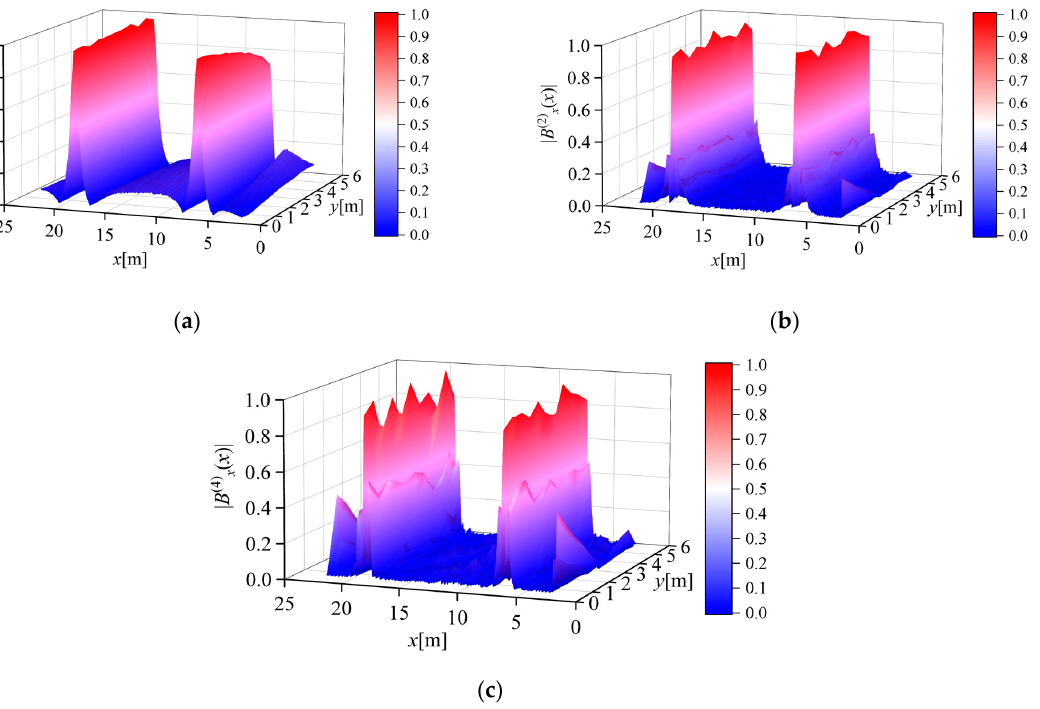
Figure 12. Normalized magnetic fl ux density absolute value measurement results when the measurement step size d = 0.05 m: ( a ) magnetic fl ux density; ( b ) second-order di ff erential of the magnetic fl ux density; ( c ) fourth-order di ff erential of the magnetic fl ux density.